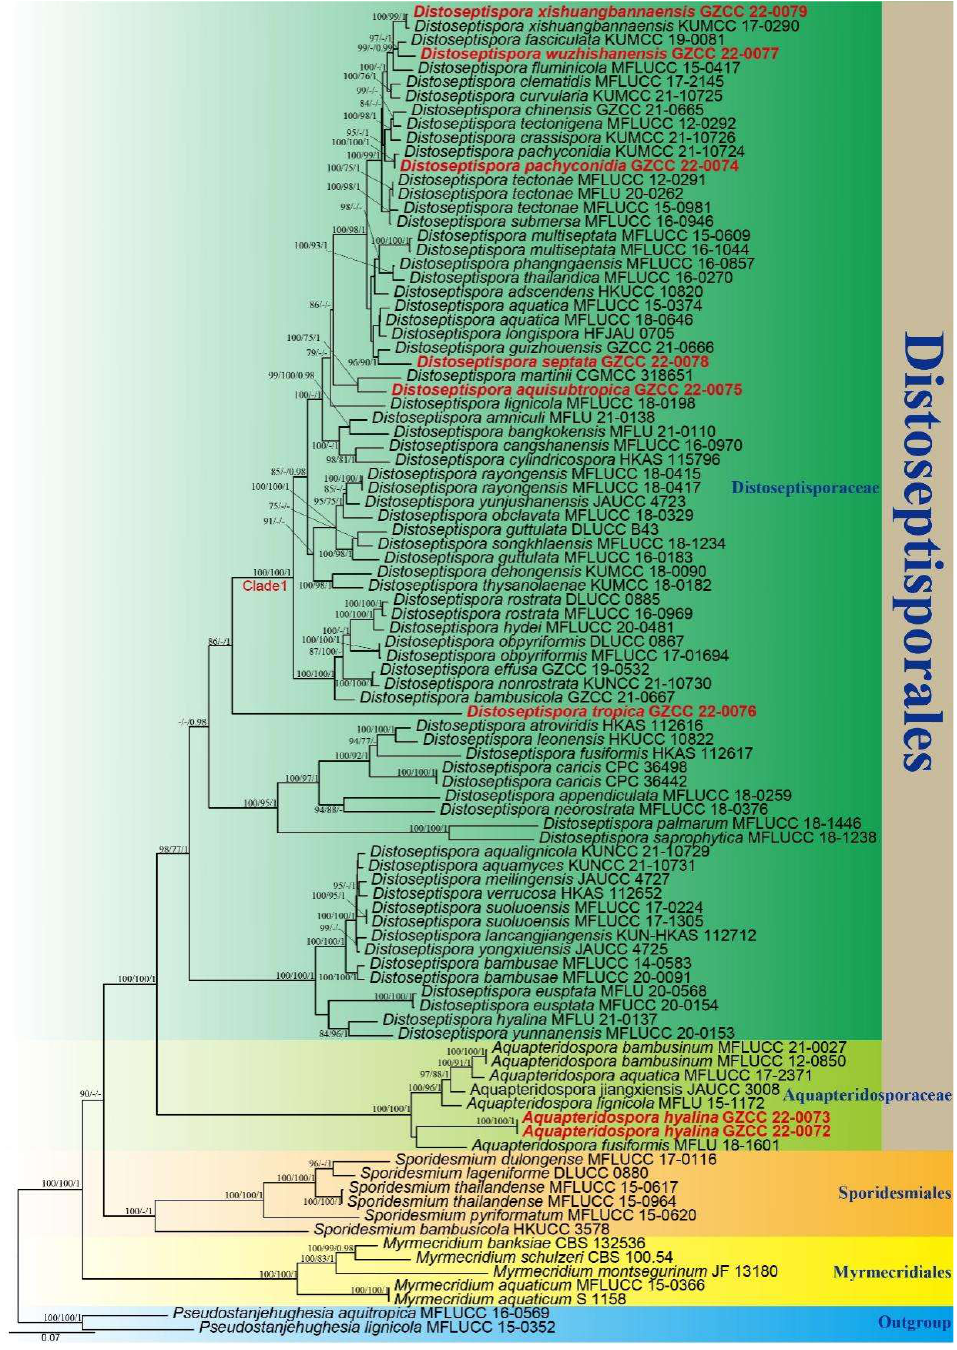
Figure 2. Phylogenetic tree generated from maximum likelihood (ML) analysis based on a combined of LSU, ITS, tef1α , and rpb2 sequence data. Bootstrap support values of maximum likelihood (ML) and Maximum Parsimony (MP) equal to or greater than 75%, and Bayesian posterior probabilities (PP) equal to or greater than 0.95 are given near the nodes as ML/MP/PP. T Pseudostanjehughesia aquitropica (MFLUCC 16-0569) and Ps . lignicola (MFLUCC 15-0352) were used as outgroup taxa. The newly generated sequences are indicated in red bold.